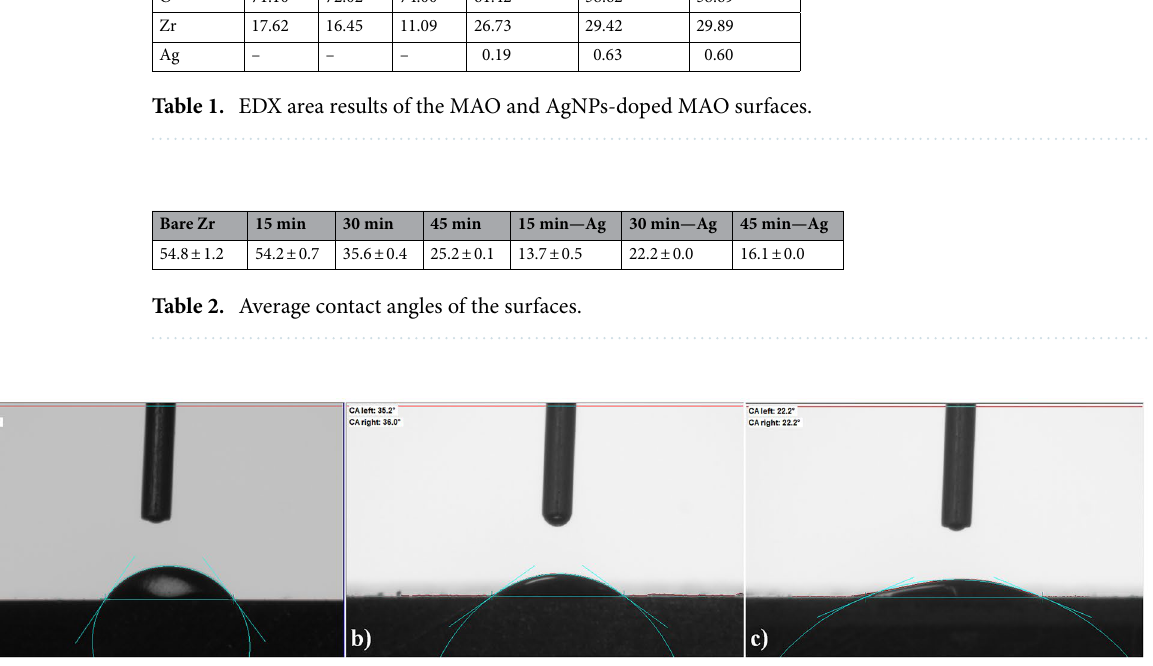
Figure 7. Contact angle images of the surfaces: ( a ) bare Zr, ( b ) MAO-30 and ( c )